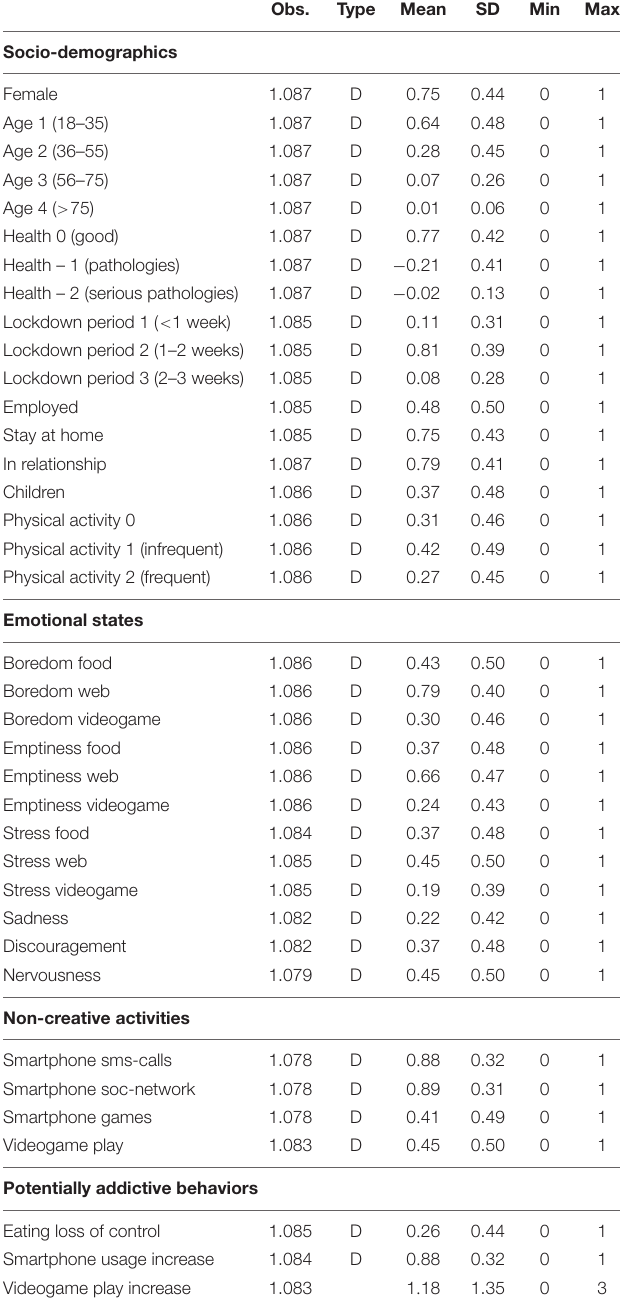
TABLE 1 | Summary statistics of selected